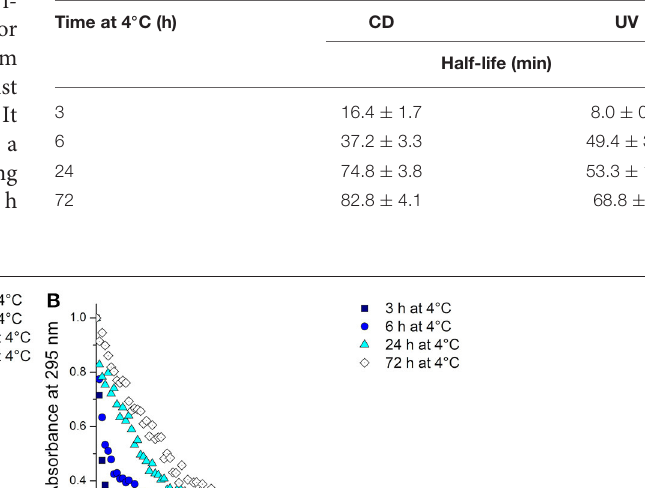
TABLE 1 | Half-life values calculated from fitting ellipticity at 288nm (CD) and normalized absorbance at 295nm (UV) to one-phase exponential decay functions